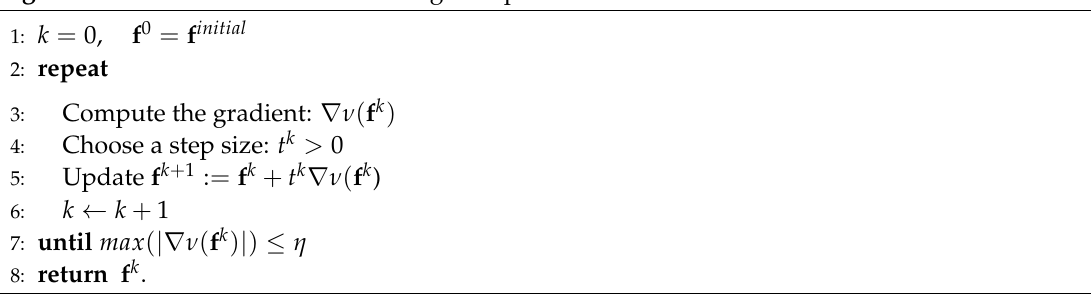
Algorithm 1 Gradient Ascent for solving the